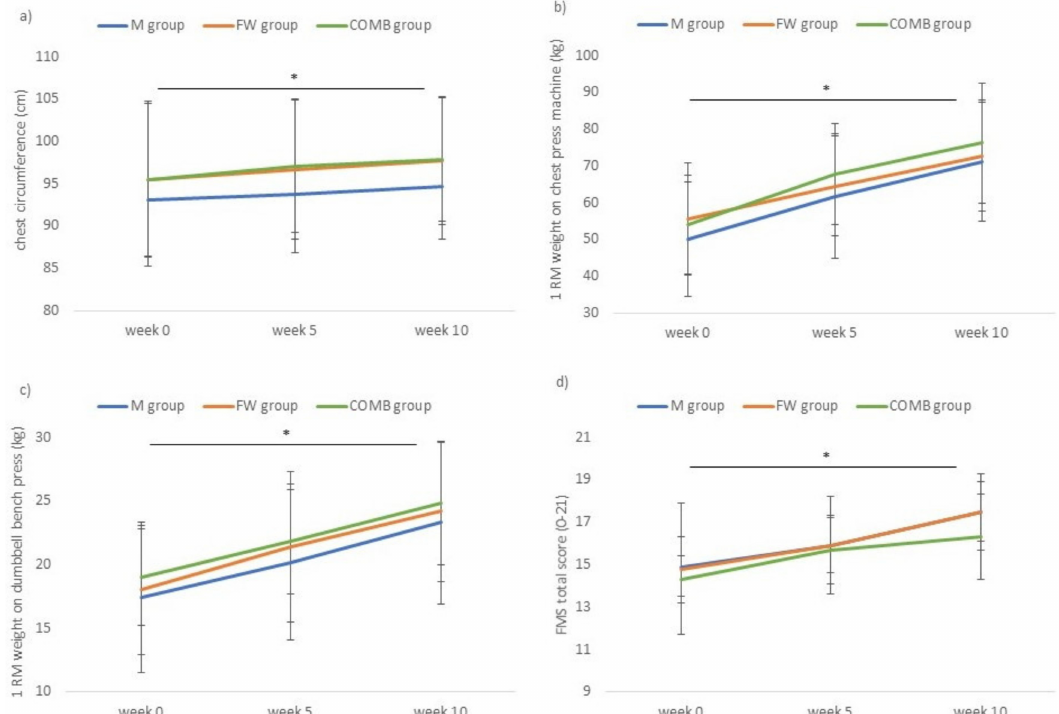
Figure 1. Evolution over the three test occasions of the three RT groups for ( a ) chest circumference, ( b ) 1-RM on chest press, ( c ) 1-RM on dumbbell bench press, ( d ) FMS total score. M, RT group using machines (N = 12); FW, RT group using free weights (N = 12); COMB, RT group changing from machines to free weights after 5 weeks (N = 12); FMS, Functional Movement Screen TM ; *: significant time e ff ect at p <